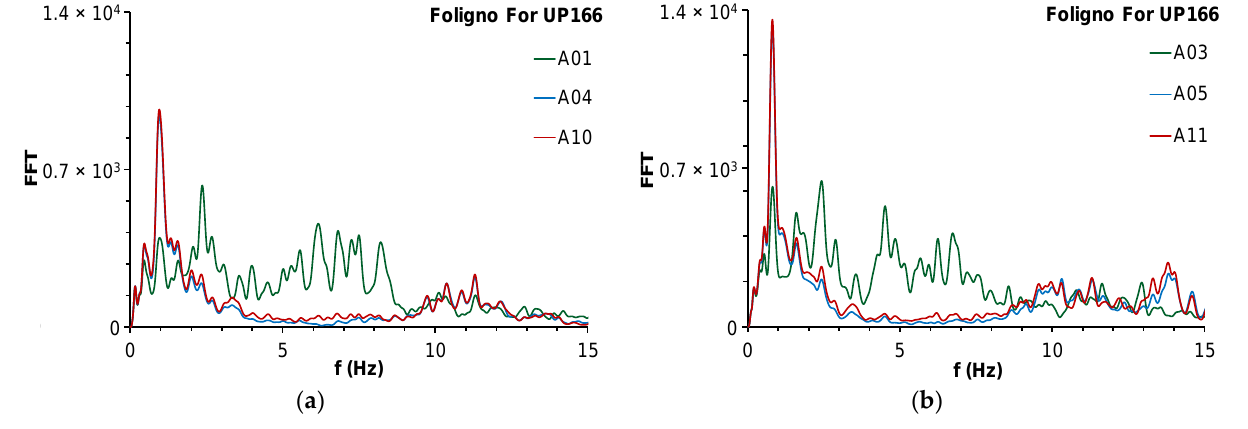
Figure 6. Fourier spectrum amplitude at different levels obtained during the 30 October 2016 Norcia Earthquake in ( a ) x direction and ( b ) y direction.